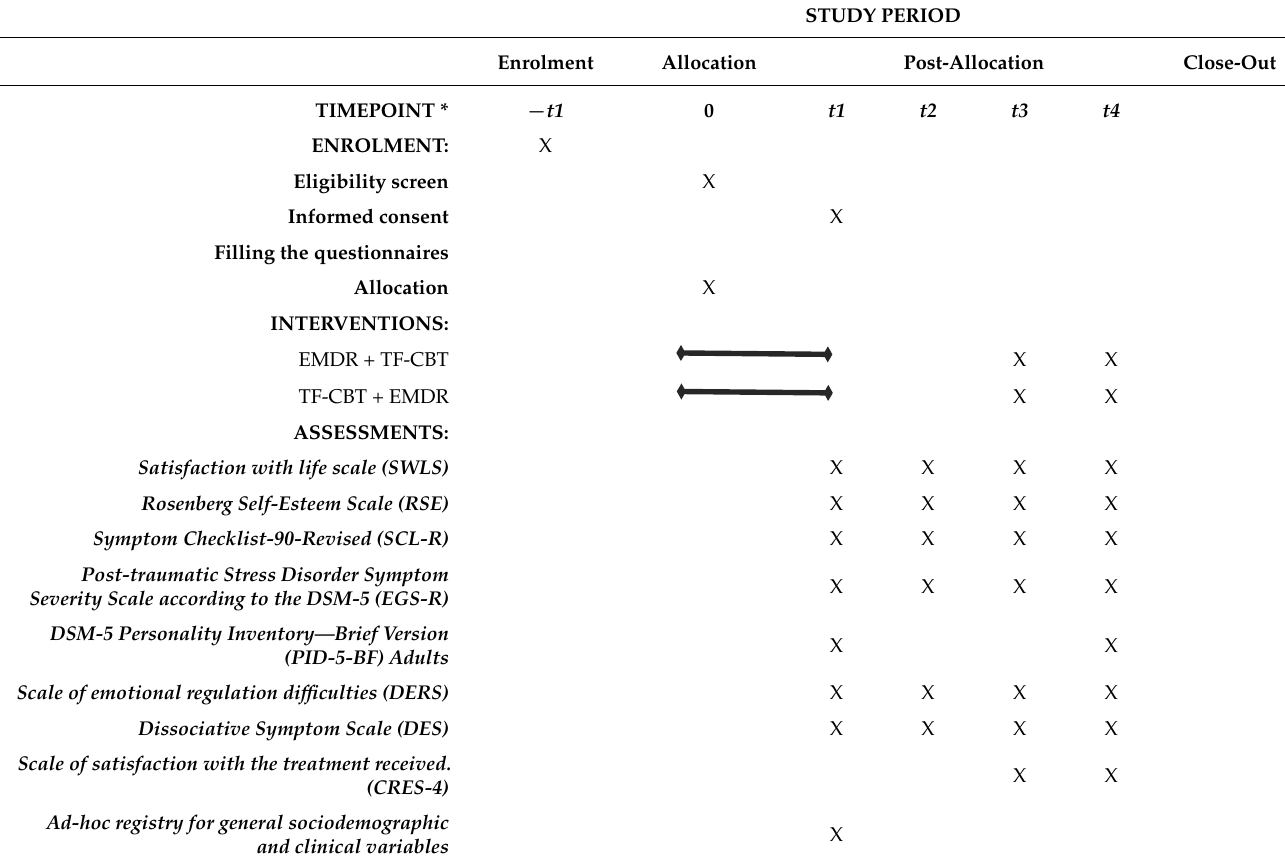
Table 1. Example template of recommended content for the schedule of enrolment, interventions, and assessments.